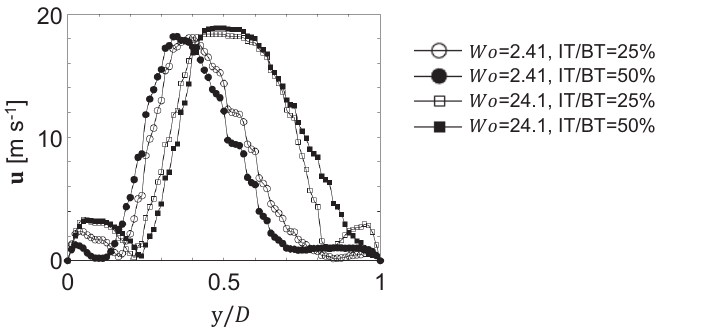
Figure 9. Three-dimensional velocity ( u ) extracted at the upper trachea (line 1-1’ at the coronal plane) as a function of non-dimensional diameter y / D , where D = trachea diameter = 18 mm.